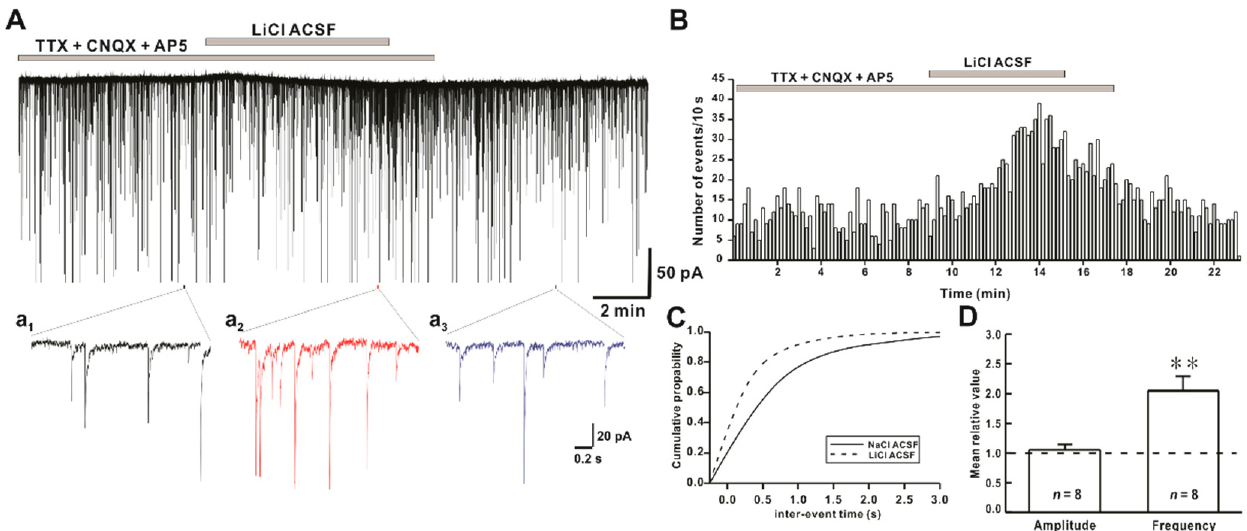
Figure 2. Effect of Li + on miniature inhibitory postsynaptic currents (mIPSCs) on hPOA neurons. ( A ) A representative current trace of mIPSCs recorded in the presence of Na + and Li + ACSF on hPOA neurons at a holding potential of − 60 mV. ( a 1 – a 3 ), sections of the current trace in Figure 2A show mIPSCs before, during, and after perfusion of Li + at 2-s intervals, respectively. ( B ) A spike frequency histogram of the current trace in Figure 2A. ( C ) A cumulative probability plot of mIPSCs inter-event interval (IEI) in the presence of Na + (solid line) and Li + (dotted line). Note that the cumulative probability curve was left-shifted by Li + , indicating the increase of mIPSCs frequency (Kolmogorov-Smirnov test, p < 0.05). ( D ) Mean relative amplitude and frequency of mIPSCs in LiCl ACSF compared to NaCl ACSF (** p < 0.01 by paired t ‐ test).